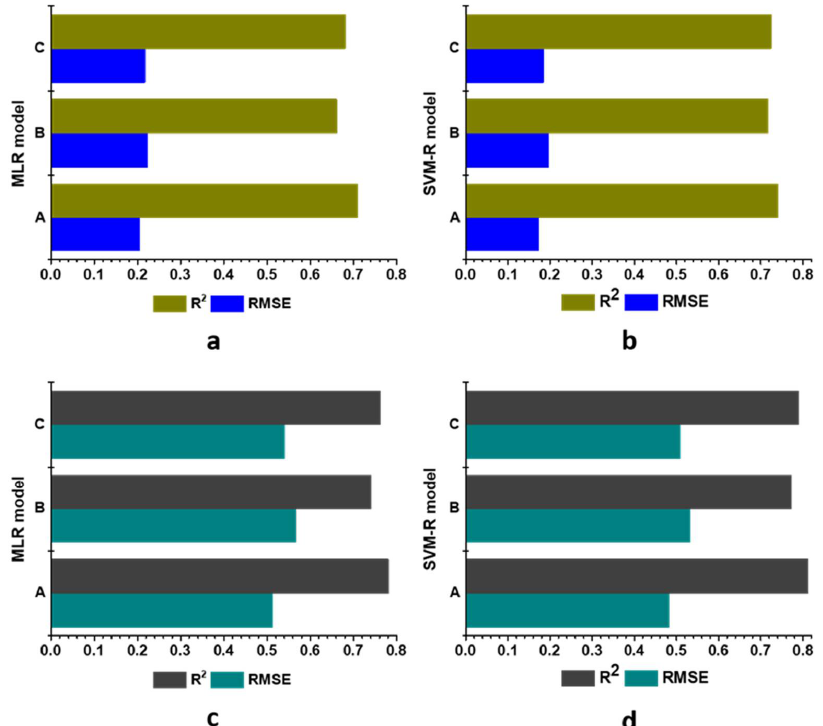
Figure 12. Sensitivity analysis of the HSV colour spaces on pH and TSS of strawberry fruits using MLR and SVM-R models. A: MLR/SVM-R model without V values; B: MLR/SVM-R model without S values; C: MLR/SVM-R model without H values. Sensitivity analysis of the HSV colour spaces on pH using MLR model ( a ); Sensitivity analysis of the HSV colour spaces on pH using SVM-R model ( b ); Sensitivity analysis of the HSV colour spaces on TSS using MLR model ( c ); Sensitivity analysis of the HSV colour spaces on TSS using SVM-R model ( d ).